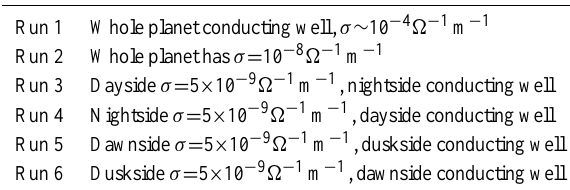
Table 1. Simulation